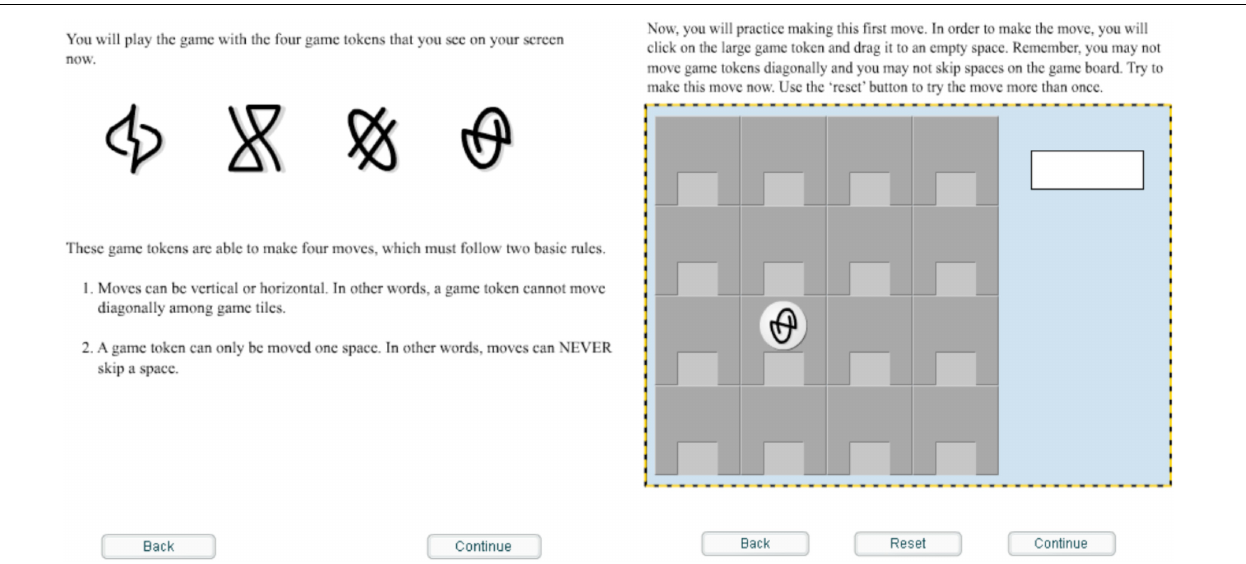
FIGURE 1 | Screenshot of training on the Brocanto2 paradigm. Note that the icons are presented without any outline of a shape around it until it is used as a token on the board game.